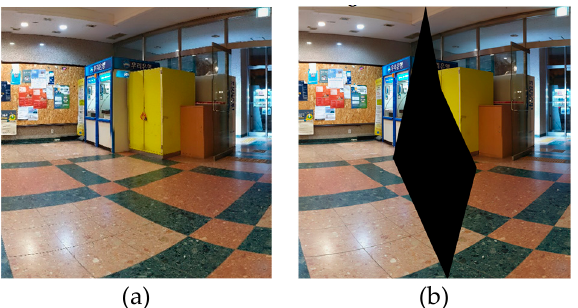
Figure 12. Example of reference picture and the original picture with a large artificial hole for test set Hallway: ( a ) Reference picture with no hole; ( b ) Original picture with a hole.